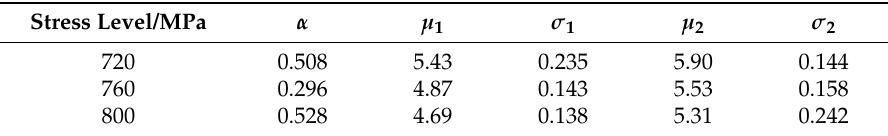
Table 2. Bimodal lognormal distribution (BLG) parameters estimated by maximum likelihood estimation